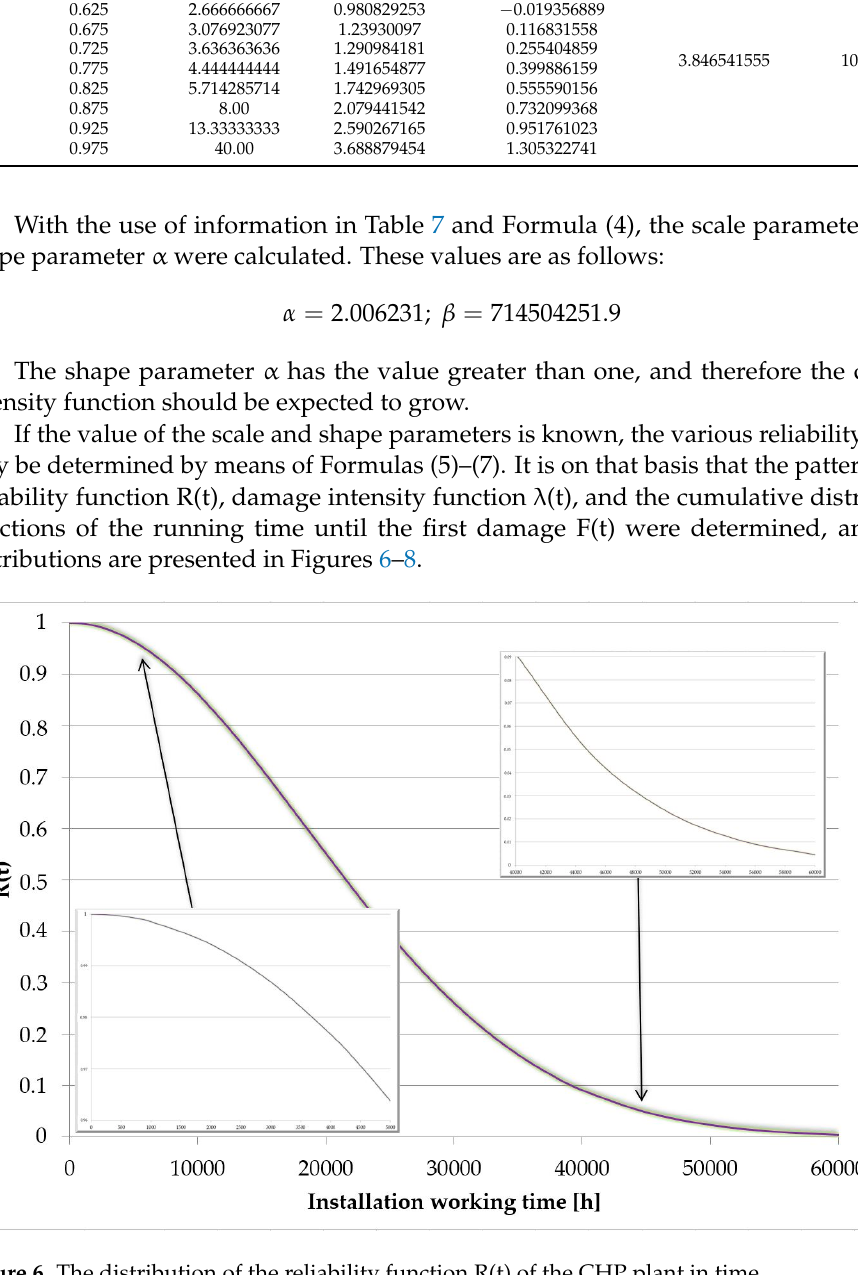
Figure 7. Distribution of the reliability function R(t) and the cumulative distribution functions of the running until the first damage F(t) of the CHP plant in time.